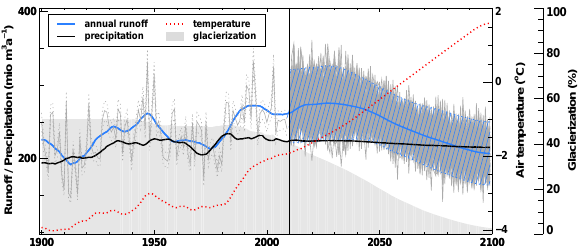
Fig. 7. Evolution of annual runoff, precipitation, air temperature and glacierization in the Mauvoisin catchment. Bold lines represent run- ning means, the thin grey line the effective evolution of the annual runoff. The blue hatched zone shows the 95% confidence interval of the annual runoff determined from multiple model runs. The grey dotted lines indicate the 95% confidence interval of the effective annual runoff evolution in the past based on the bias between mod- elled and measured annual runoff. The grey shaded area refers to the percentage of the ice covered area in the catchment.